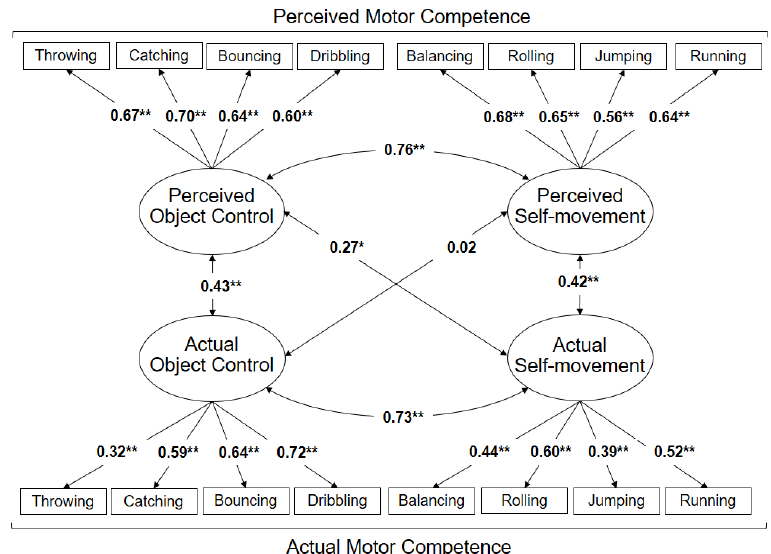
Figure 1. Relations between the factors of actual and perceived motor competence (MC) (model 1). * Significant di ff erences at the level of p ≤ 0.05; ** Significant di ff erences at the level of p ≤